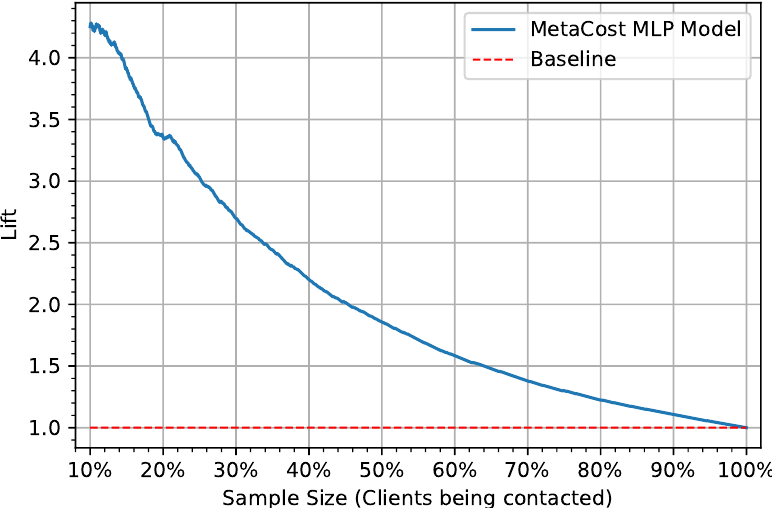
Figure 5. Lift Curve, Meta-Cost using MLP with FN-Cost Factor of